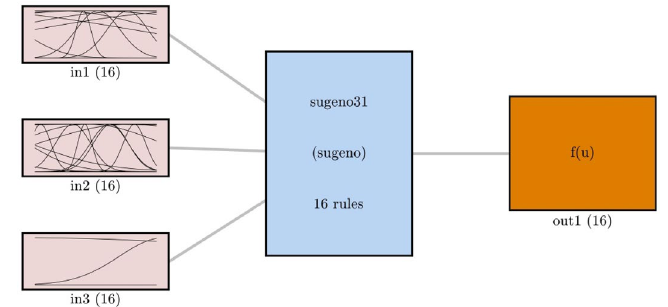
Figure 6. FIS structure in the best results.